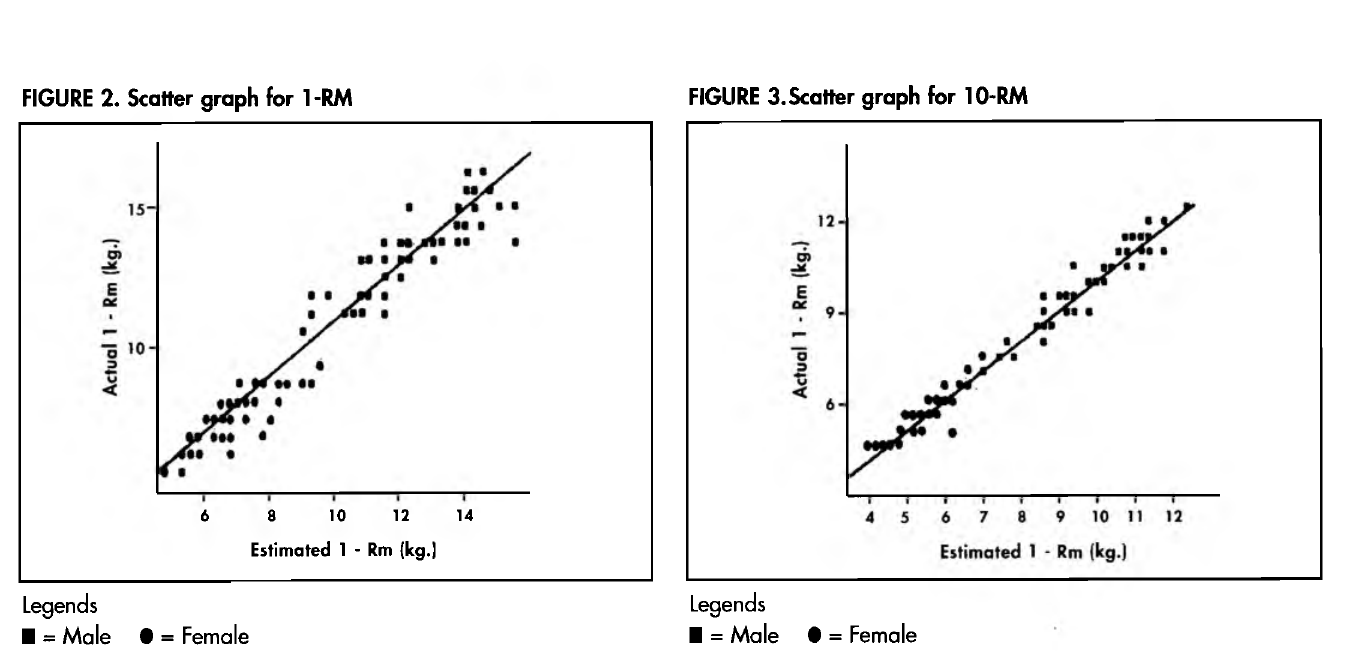
FIGURE 2. Scatter graph for 1 -RM FIGURE 3. Scatter graph for